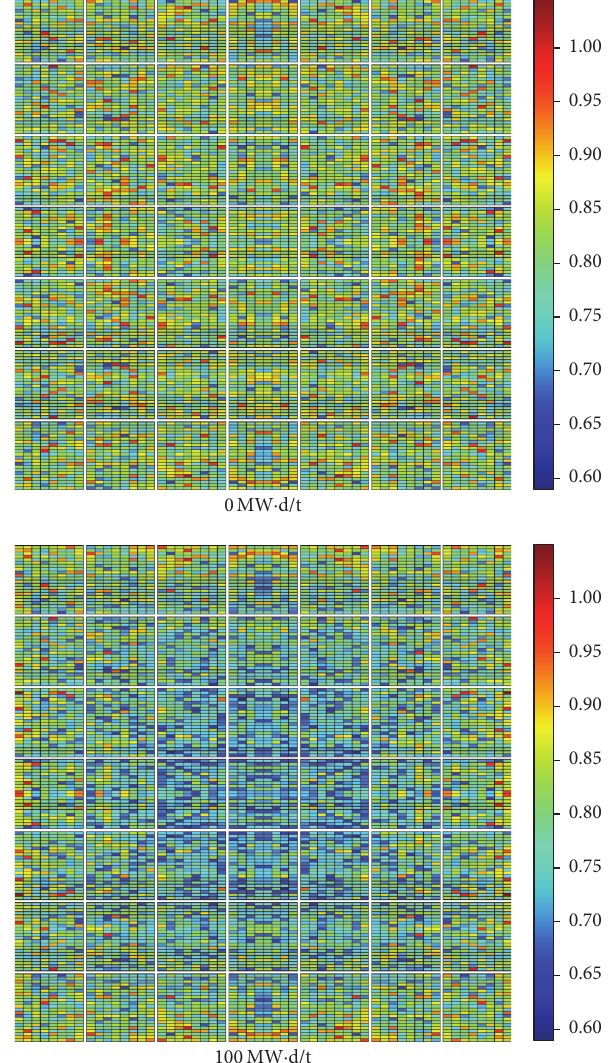
Figure 6: Uncertainty on power factors (%) coming from